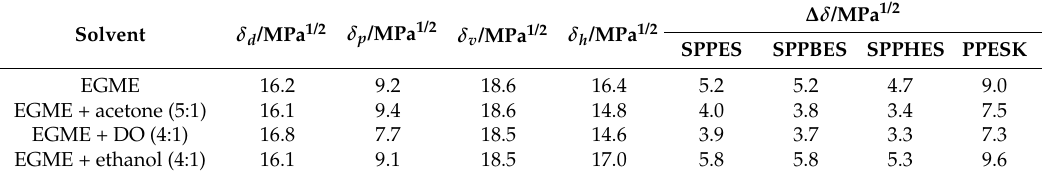
Table 2. Comparison of solubility parameters between sulfonated poly(aryl ether sulfone)s, PPESK, and solvents.